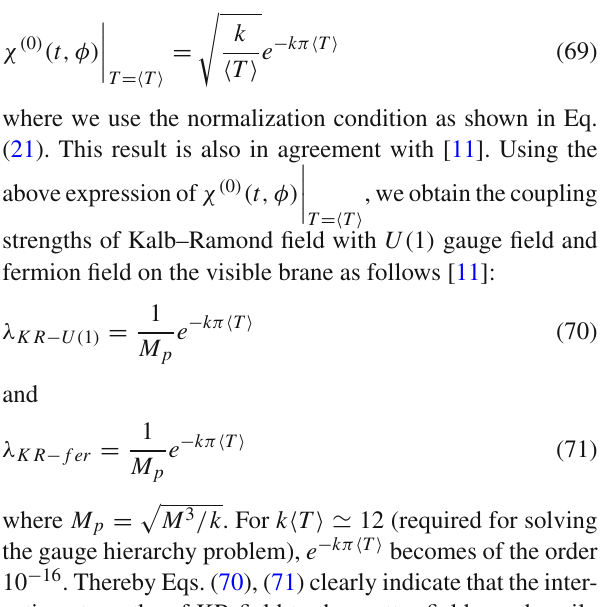
bulk i.e for 0 ≤ φ ≤ π . However for a fixed t , χ ( 0 ) ( t , φ) has different values (in Planckian unit) on hidden and visible brane and such hierarchial nature of χ ( 0 ) ( t , φ) (between the two branes) is controlled by the constant b